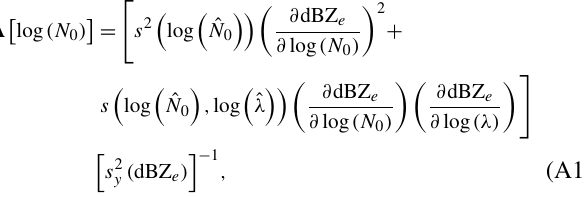
Figure A1. Schematic illustration of the retrieval process. The solid line represents the initial state of the retrieval, while the dashed line shows the adjusted state assuming the initial state overestimates the observed reflectivity. The arrows labeled δ log (λ) and δ log (N 0 ) show the expected responses of the retrieval based on the sensitiv- ities of the forward model. The arrow labeled s ( log (N o ), log (λ)) shows the response due to positive covariance between λ and N 0